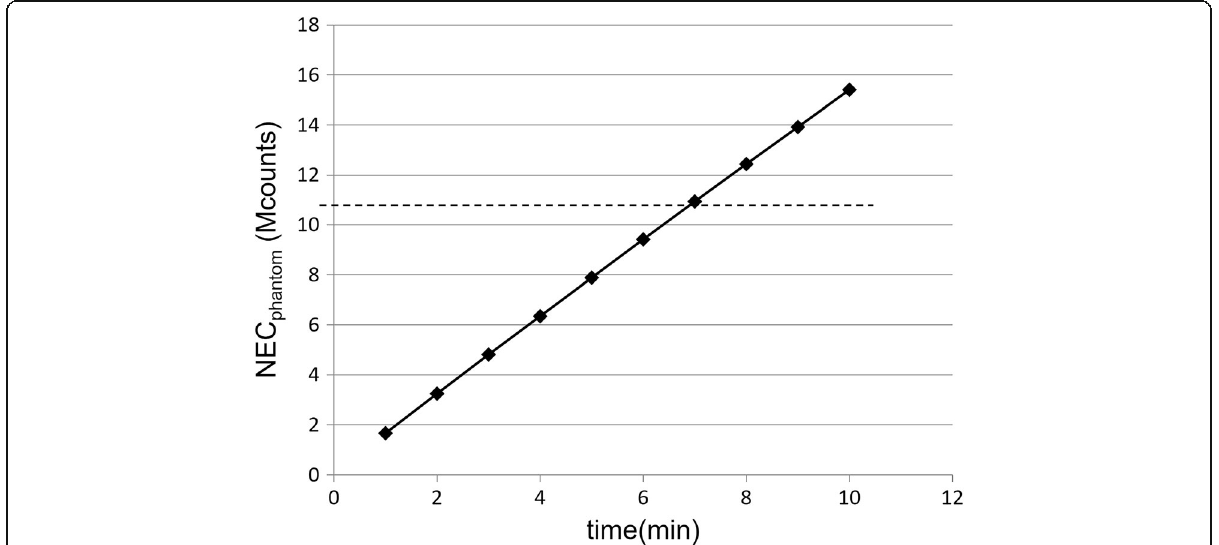
Fig. 7 Noise equivalent counts (NEC phantom ) measured for 1 – 10 min of scanning time (1-min intervals). The dotted line indicates the value recommended in the Japanese guideline (10.8